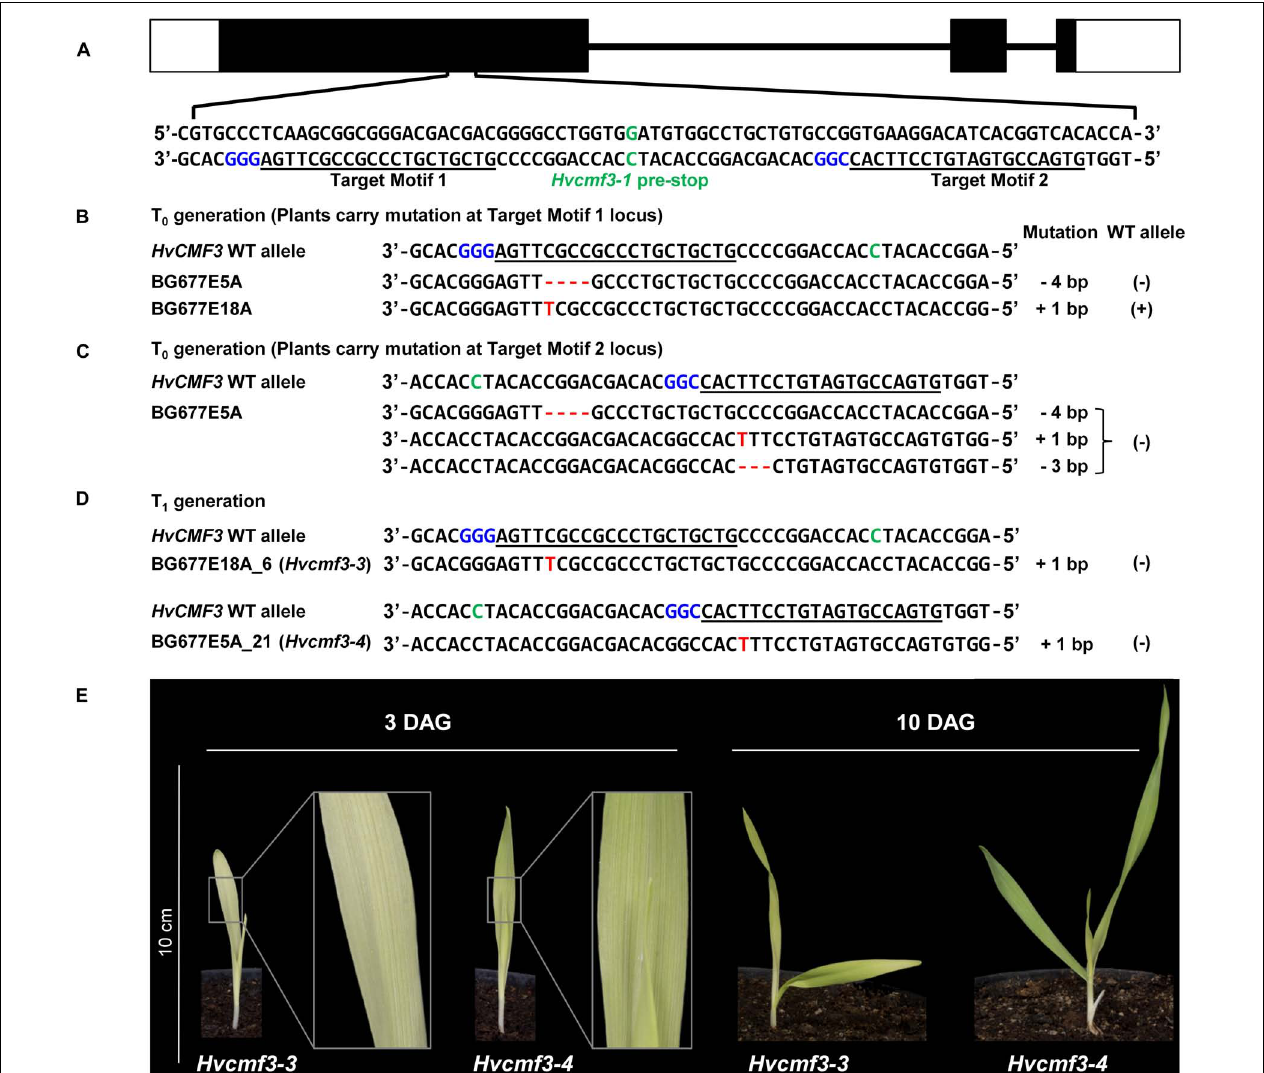
FIGURE 3 | Site-directed mutagenesis of HvCMF3 gene by RNA-guided Cas9 endonuclease. (A) Selection of Cas9/gRNA target sites. The two target motifs (Target Motif 1 and 2) in the anti-sense strand are underlined; the respective protospacer adjacent motif is highlighted in blue. The nucleotide in green color indicates the position of the pre-stop mutation in the Hvcmf3-1 mutant. (B) Alignment of HvCMF3 sequences of wild type and T 0 plantlets carrying mutations at target motif 1. (C) Alignment of HvCMF3 sequences of wild type and T 0 plantlets carrying mutations at target motif 2. The chimeric and/or heterozygous T 0 regenerant BG677E5A carries multiple mutations with each mutation shown in one single row. (D) Alignment of HvCMF3 sequences of wild type and T 1 homozygous mutant plants. Across panels, deletions are represented by red hyphens and insertions by red letters. The specific mutation of each plant is shown on the right of each sequence; presence/absence of wild type allele is indicated by symbols ± , respectively. (E) Phenotype of Cas9-induced homozygous Hvcmf3 mutants at developmental stages 3 and 10 days after germination.